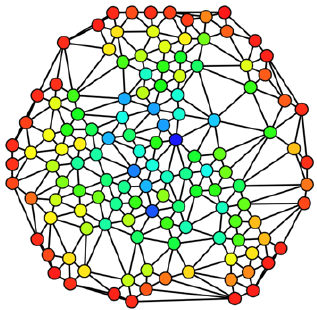
Figure 9. Clusters generated from Graph clustering